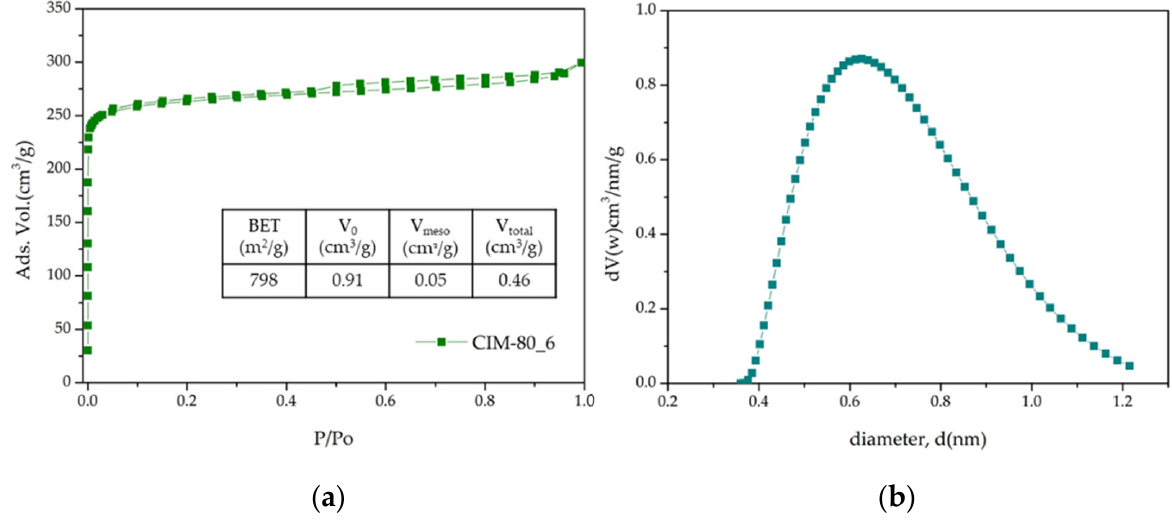
Figure 4. ( a ) N2 adsoprtion isotherm; ( b ) pore size distribution of sample